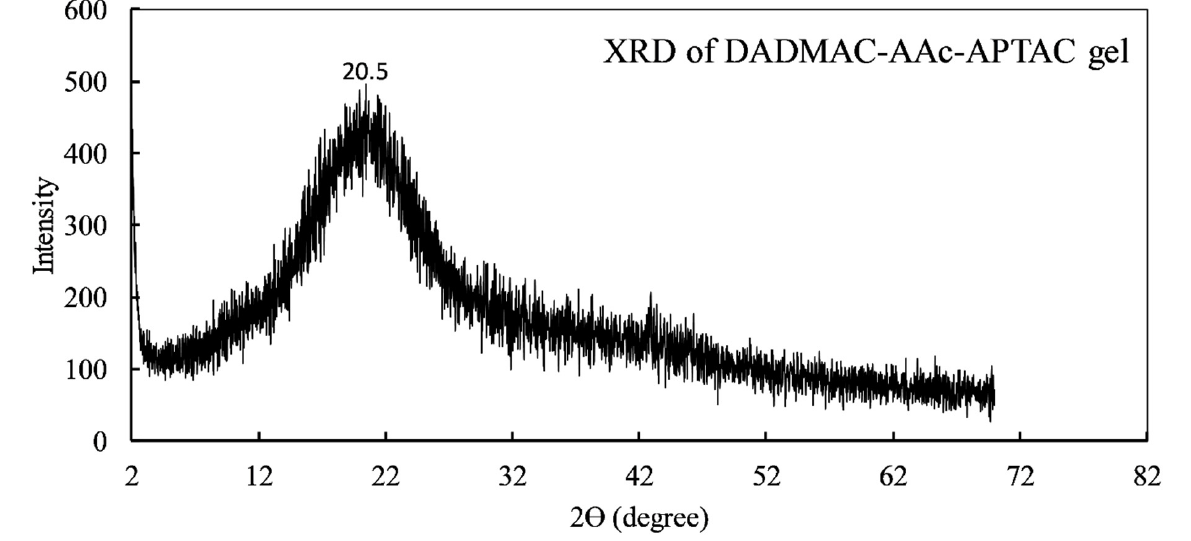
Figure 5. XRD spectrum of DADMAC-AAc-APTAC hydrogel.